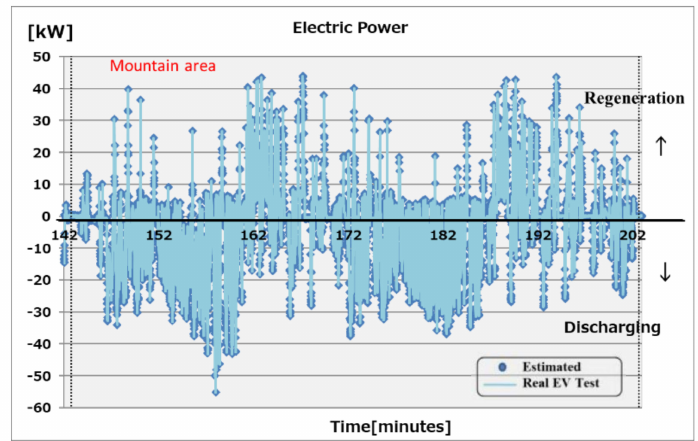
Figure 27. Estimation of power consumption for a specific terrain.